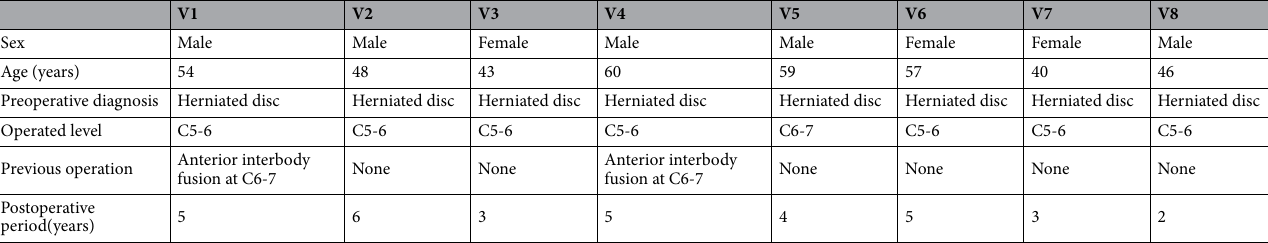
Table 3. Demographic data of volunteers